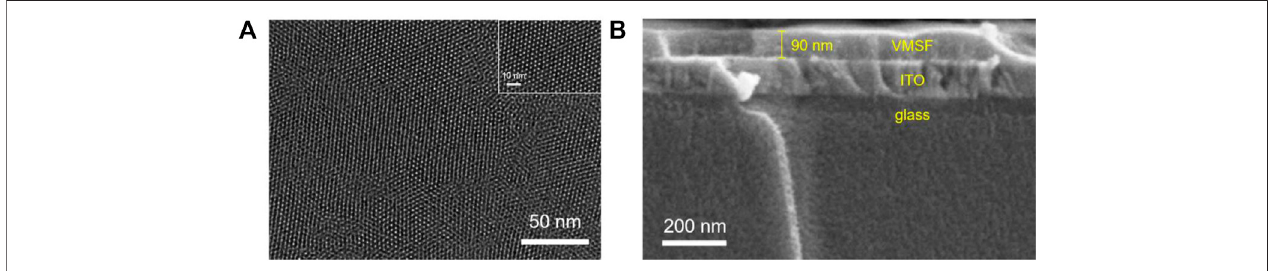
FIGURE 2 | (A) Top-view TEM images of the VMSF separated from the ITO electrode at different magni fi cation. (B) Cross-sectional SEM image of the